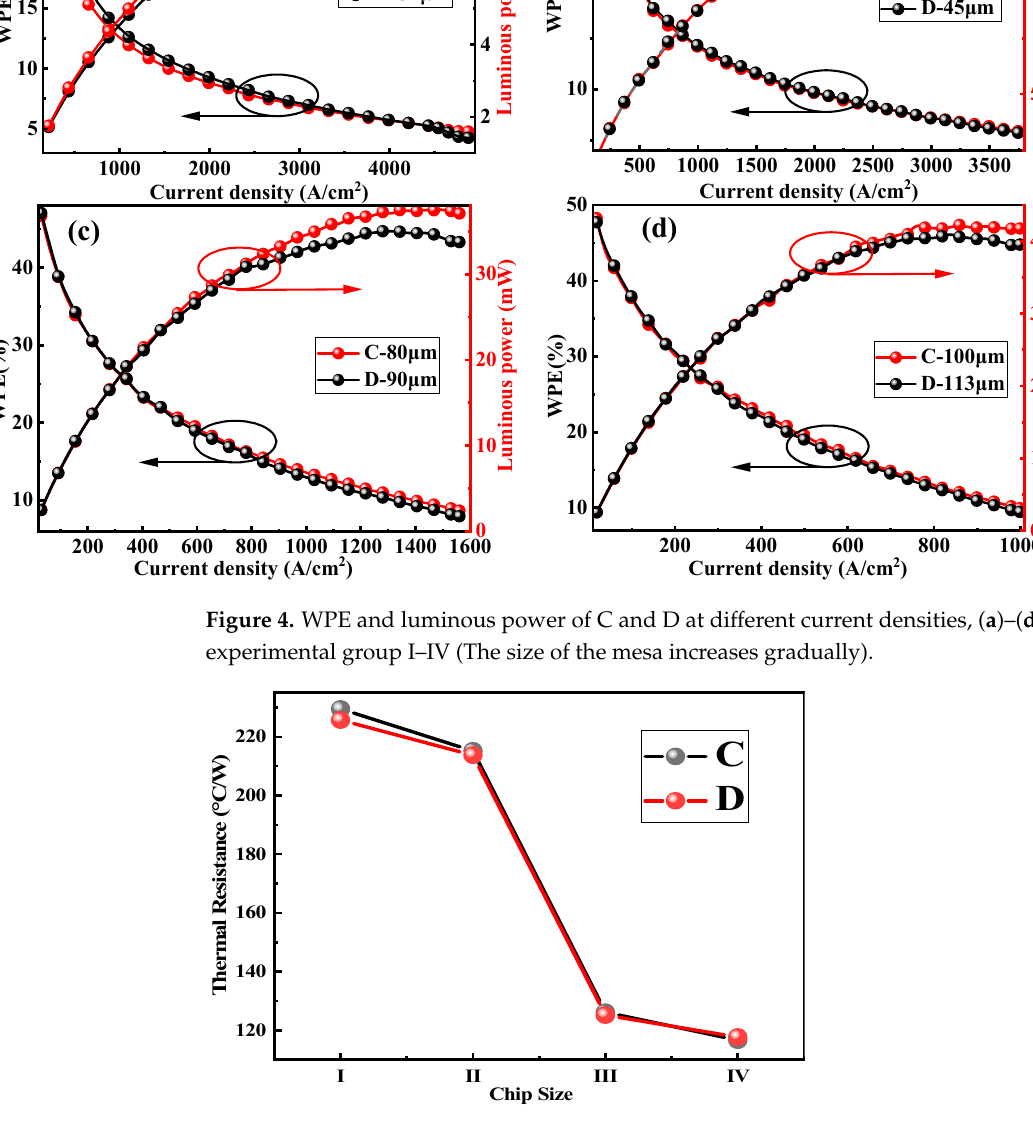
Figure 5. Thermal resistance of C and D with different mesa sizes at 20 mA current.